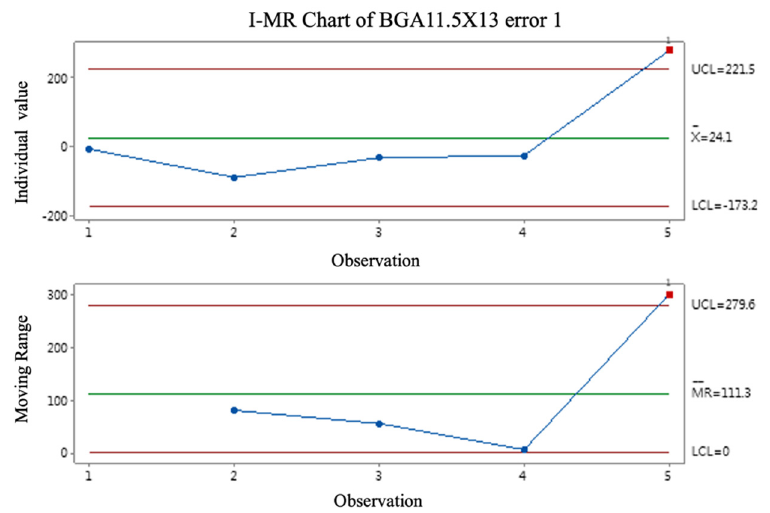
Figure 6. I-MR control chart for BGA 11.5X13 data for the first prediction roll.